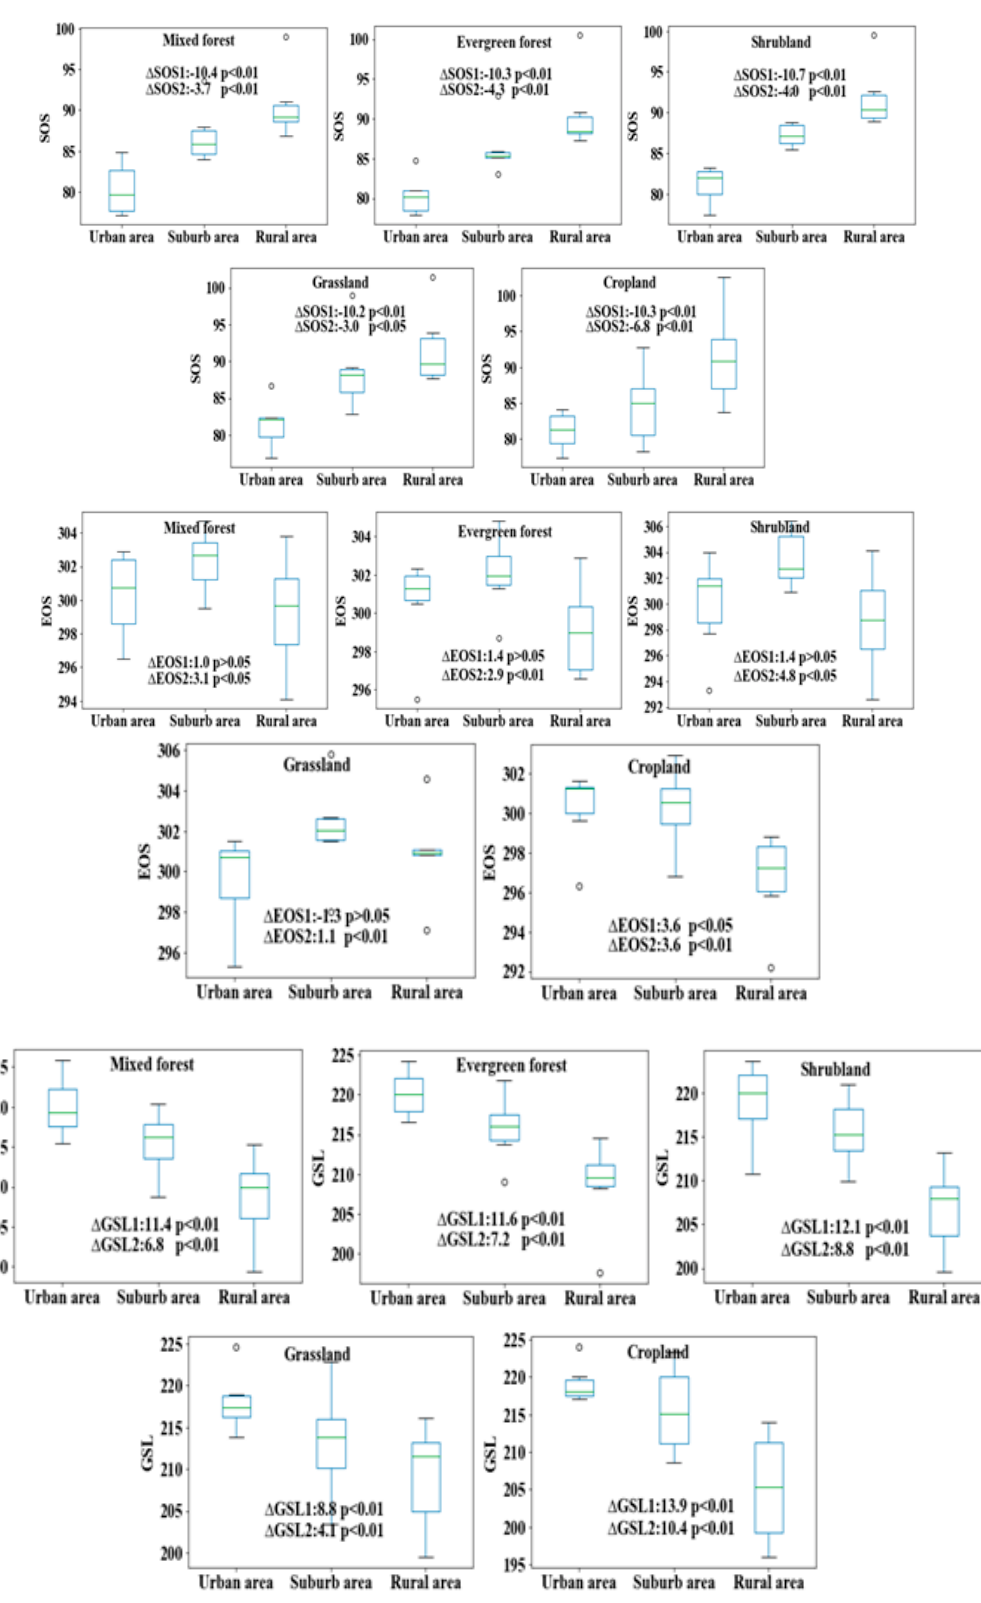
Figure 9. Mean phenology differences (2013–2018) of urban, suburban, and rural areas for different vegetation types. ∆ SOS1, ∆ EOS1, and ∆ GSL1 refer to the differences in SOS, EOS, and GSL, respectively, between urban and rural areas. ∆ SOS2, ∆ EOS2, and ∆ GSL2 are defined as the differences in SOS, EOS, and GSL, respectively, between suburban and rural areas. Table 2. Mean phenology differences (2013–2018) of urban, suburban, and rural areas for different vegetation types in units of days. Variable definitions are as in Figure 9.